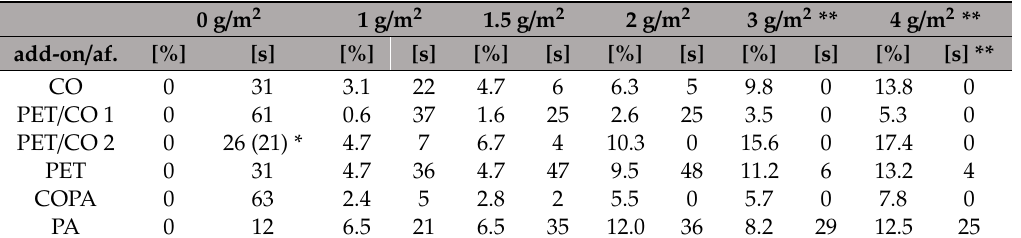
Table A4. Evolution of after-flame time in the flame test, according to DIN EN ISO 15025 after one washing cycle.